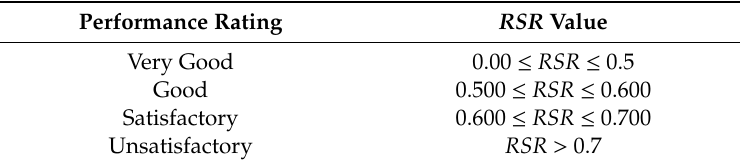
Table 5. General performance rating for the RMSE-observations standard deviation ratio ( RSR ) index [35].